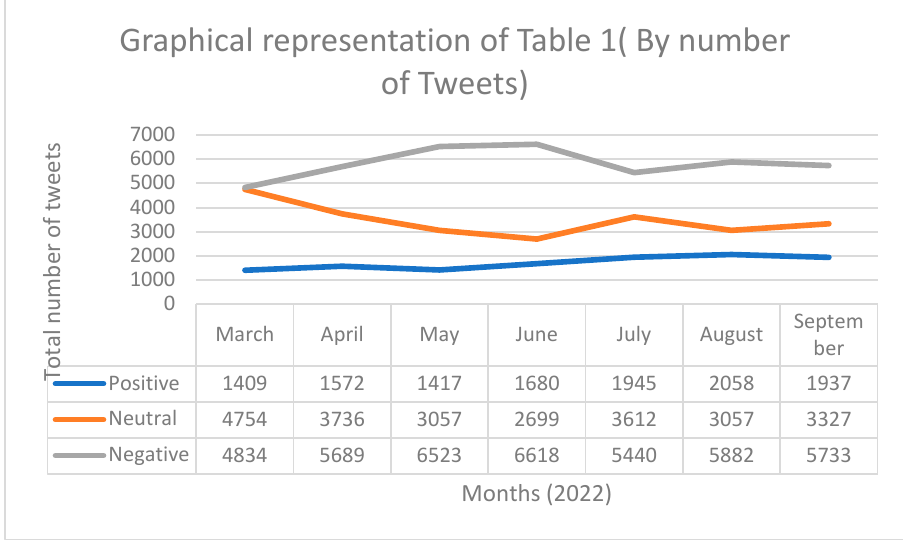
Figure 3. Graphical representation of Table 1 (by number of tweets).